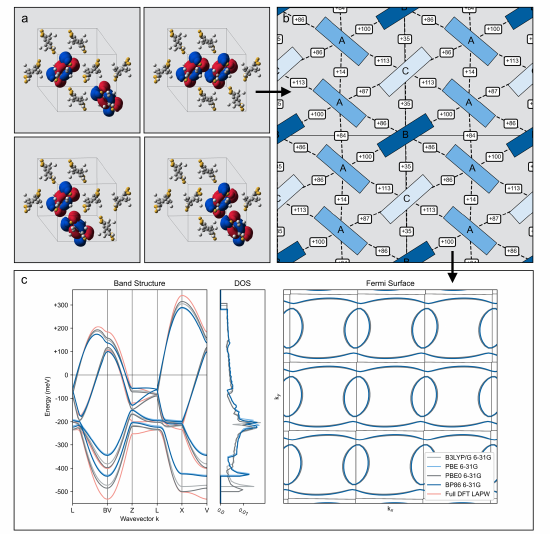
Figure 3. Views of various stages of the tight-binding electronic structure calculation. The individ- ual images show the quantum chemistry calculation of inter-molecular charge transfer integrals ( a ), site-hopping integrals model ( b ), and electronic structure ( c ). In this example the material is α -(ET) 2 KHg(SCN) 4 , as reported in [39]. Note that the WIEN2k band structure in red is close to the TB band structures, especially near the Fermi